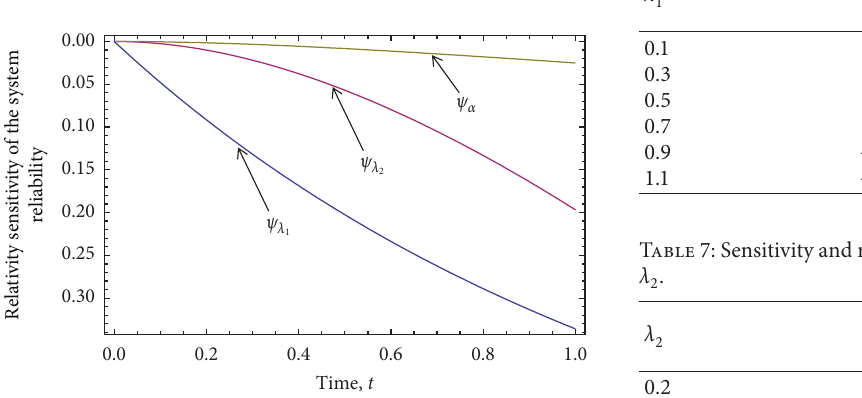
Figure 7: Relativity sensitivity analysis on reliability function t ∈ [ 0 , 1 ] .